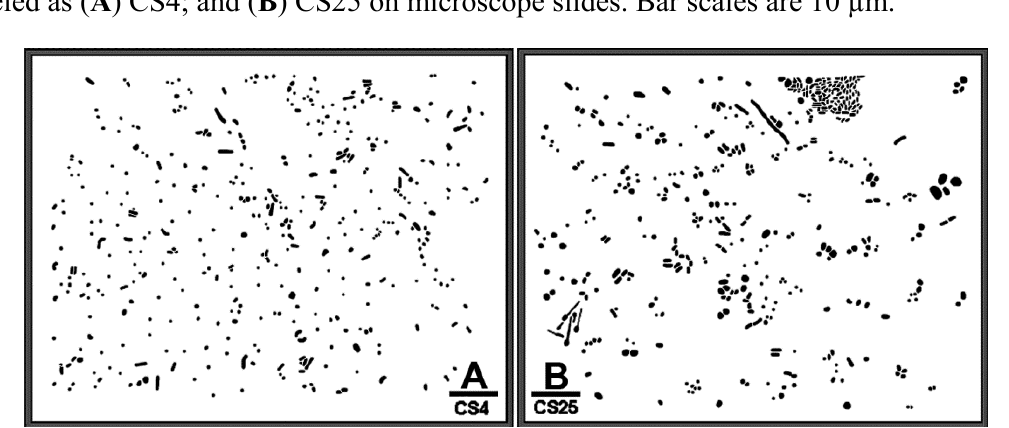
Figure 1. In situ spatial distribution of freshwater microbial assemblages in biofilms labeled as ( A ) CS4; and ( B ) CS25 on microscope slides. Bar scales are 10